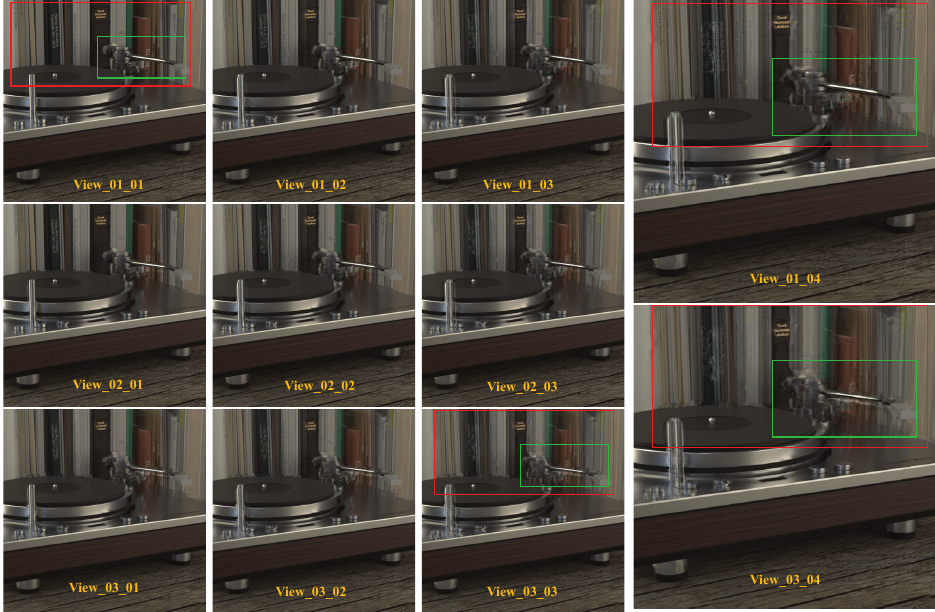
Figure 9. Results of light fields angular super-resolution on HCI dataset with low